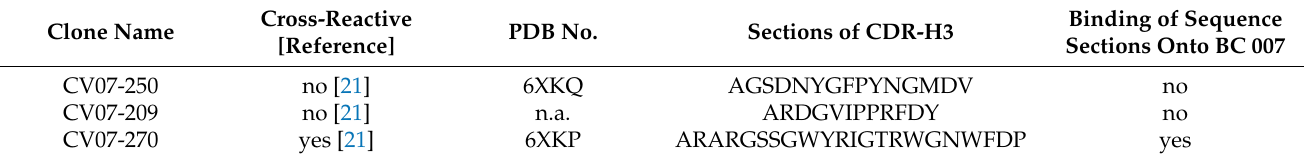
Table 1. Overview over the published and used anti-SARS-CoV-2 AB sequence sections. Clone